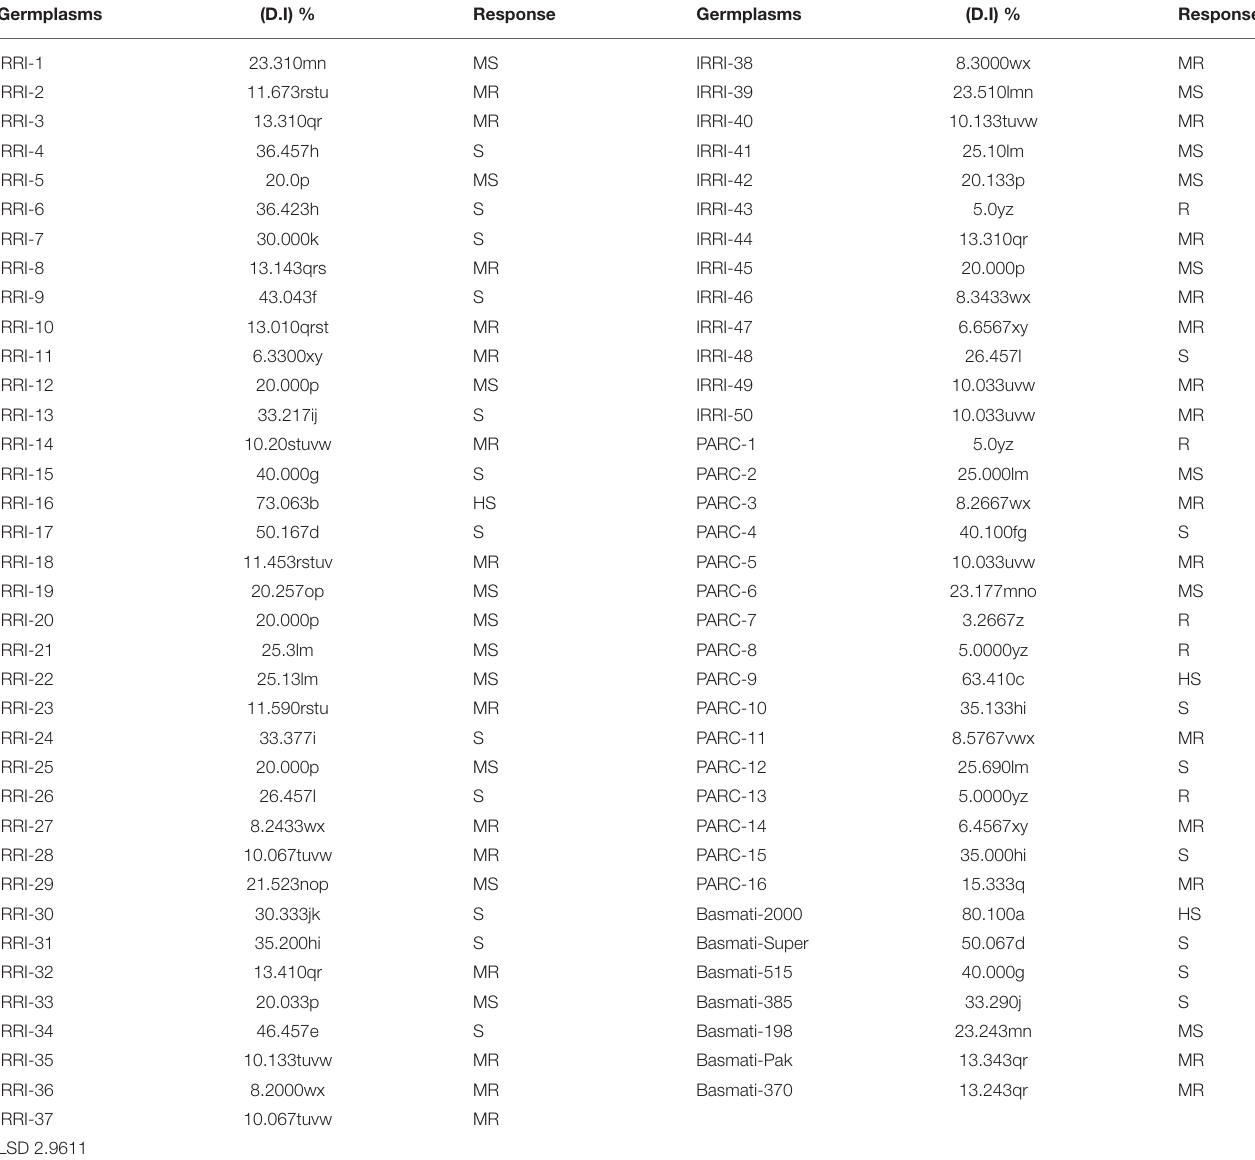
TABLE 2 | Phenotypic response of diverse rice germplasm against Brown spot disease.